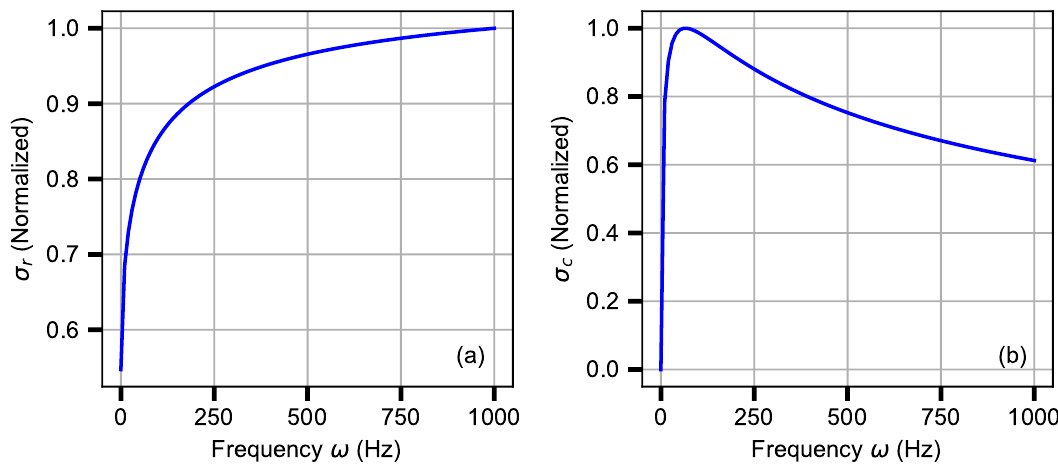
Figure 8. ( a ) Real, σ r , and ( b ) imaginary, σ c , components of complex conductivities vs. frequency. Each component of the complex conductivity was normalized with respect to its maximum value to better show